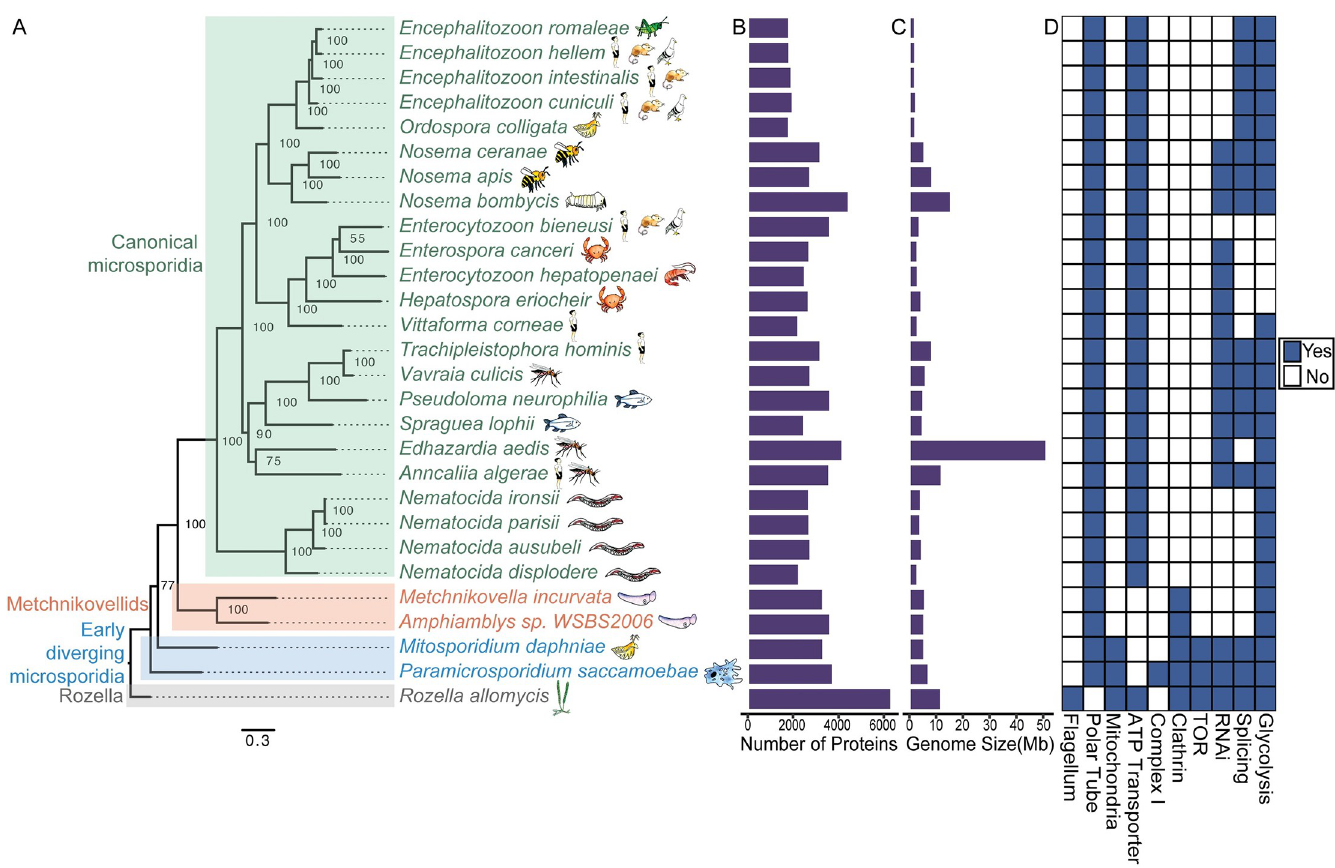
Fig 1. Phylogeny, hosts, and characteristics of microsporidia species. (A) Phylogenetic tree of whole-genome sequenced microsporidia and related species. Tree was generated as described previously using single-copy orthologs present in all species [19,35].Predicted proteins for each genome were obtained from https://www.ncbi. nlm.nih.gov, except for Metchnikovella incurvata and Enterospora canceri , which were predicted from genome assemblies using Prodigal 2.6.3. Orthologous gene families were identified using OrthoMCL 2.0.9 using an inflation index of 1.5 and a BLAST E-value cutoff of 10 − 5 . Phylogeny was constructed from 43 single-copy orthologs present in all 28 species. Proteins from each orthogroup were aligned using MUSCLE 3.8.31. These alignments were trimmed using trimAl 1.4 with the option-gappyout. Each orthogroup alignment was then concatenated into a single alignment using FASconCAT 1.11. Using ProtTest 3.4.2, it was determined that PROTGAMMAIWAGF was the best fitting model for the data. Phylogeny was then inferred using RAxML 8.2.12 with the best fitting model and 1,000 bootstrap replicates. Scale bar indicates changes per site. To the right of each species are illustrations of the host(s) that each species has been reported to infect. This phylogenetic tree is largely in agreement with recent previously published phylogenies [3,4,8,9,19,23,27], with the exception of Anncaliia algerae or Edhazardia aedis , which have different placements in several reports [3,8,23,27].(B) Comparision of protein content for each species. (C) Comparision of genome size for each species. (D) Morphological and molecular characteristics of each species. E-value, expect value; TOR, target of